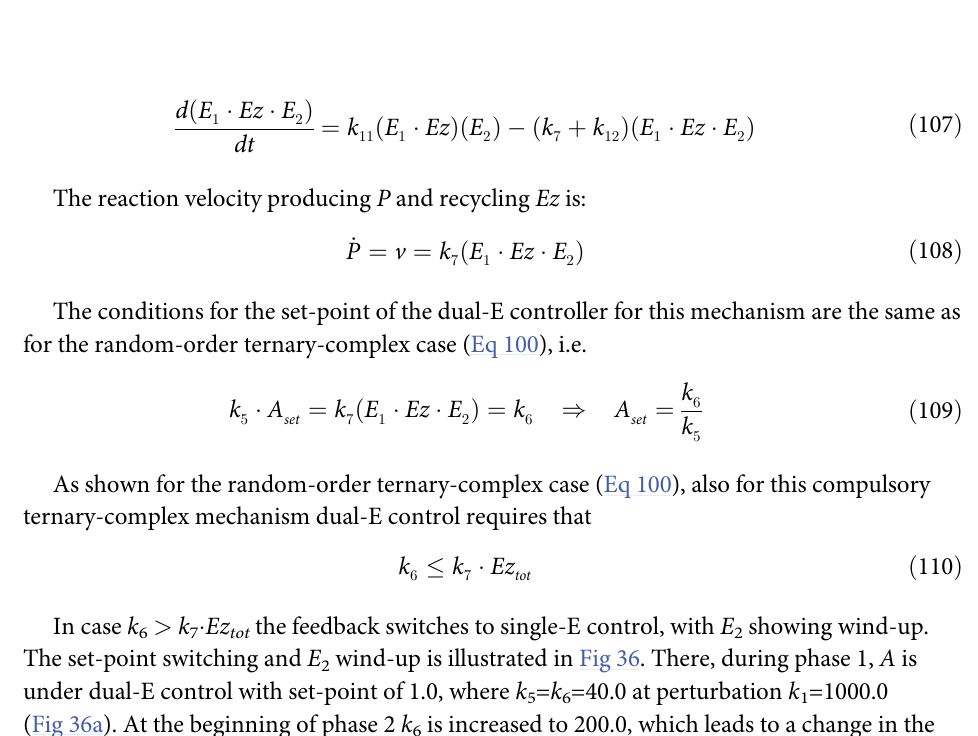
Fig 35. Scheme of the m5 controller when E 1 and E 2 are removed by a compulsory ternary-complex mechanism with E 1 binding first to the free enzyme Ez .